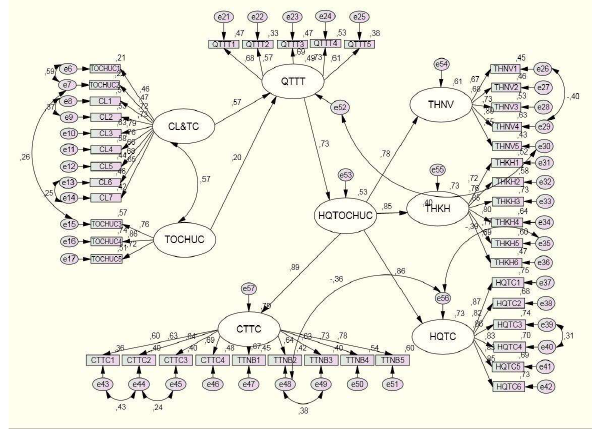
Fig. 2. Output of the second SEM model